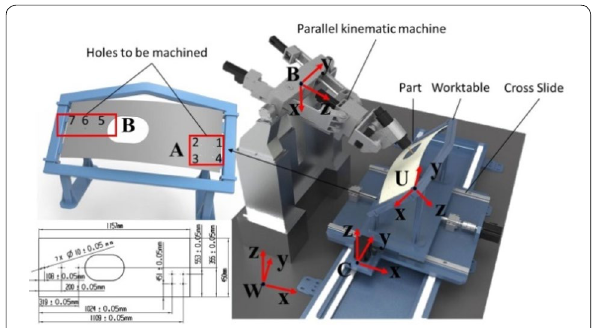
Figure 8 Optimization of working stiffness of the PKM in hole